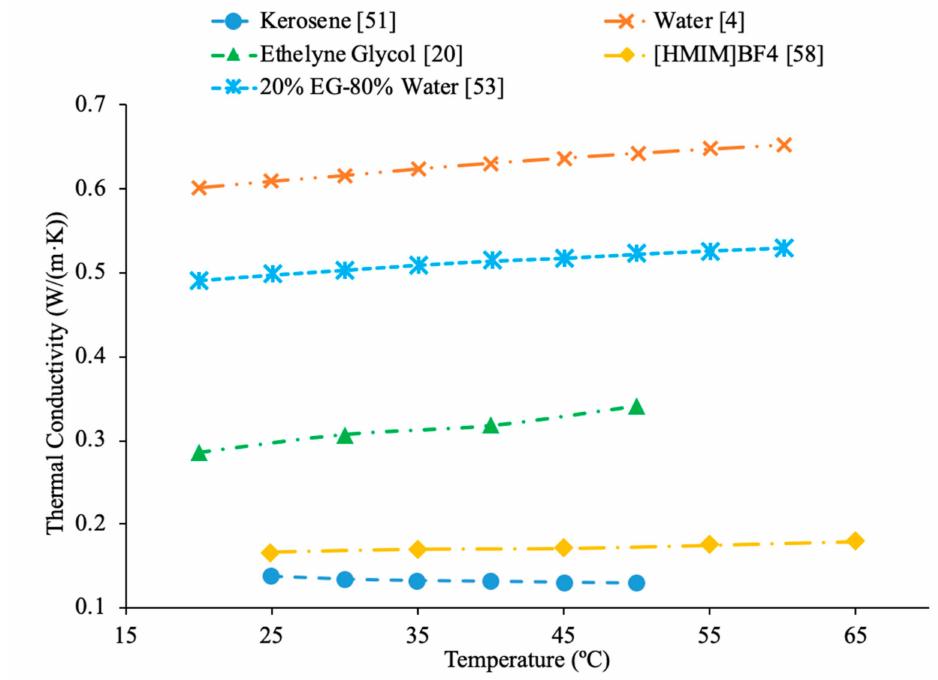
Figure 20. Thermal conductivity versus temperature for various base fluids